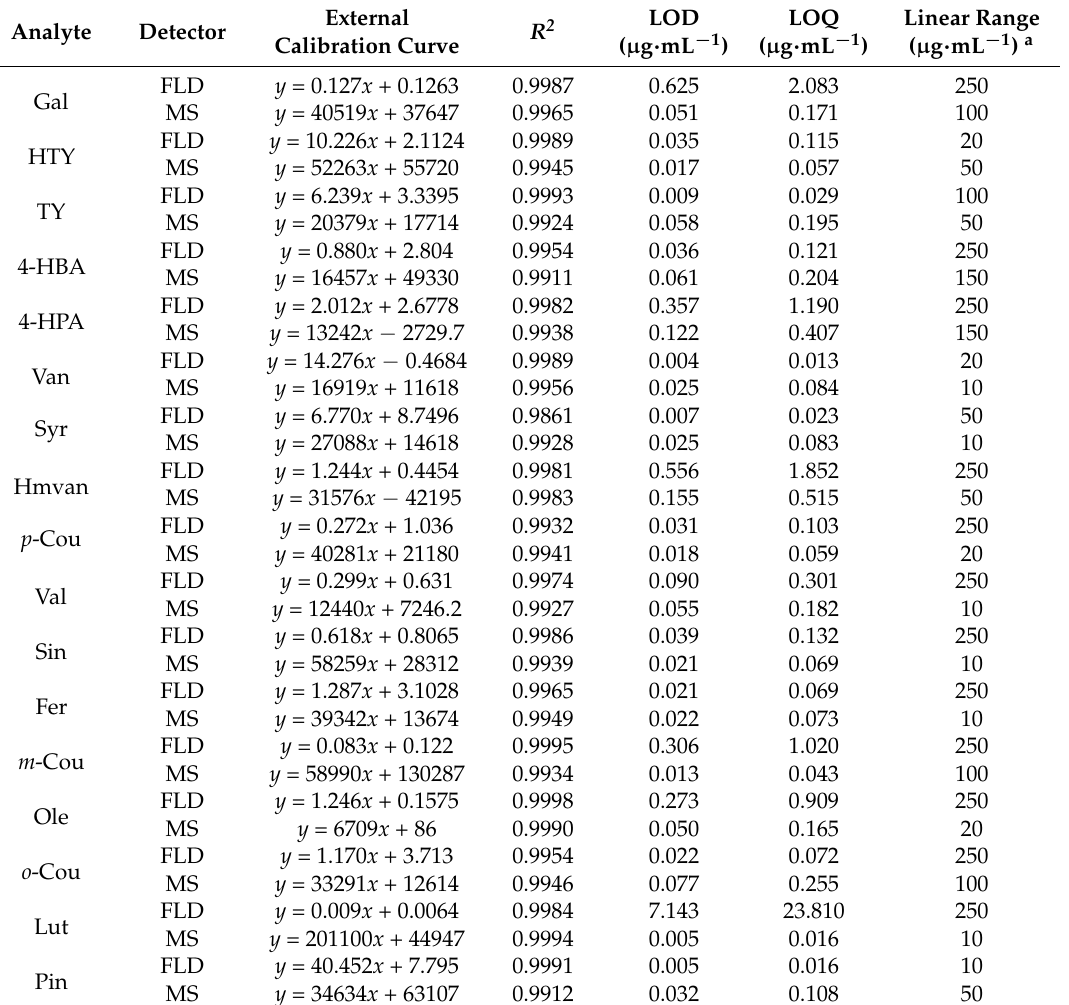
Table 2. Comparison between calibration functions, determination coefficients, LODs, LOQs and lineal dynamic ranges for the FLD and the MS